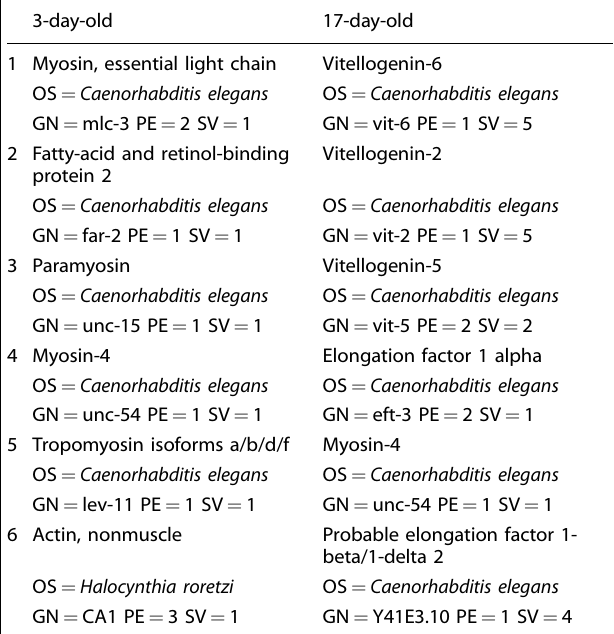
Table 1. Proteins that were found more in older worms than in young